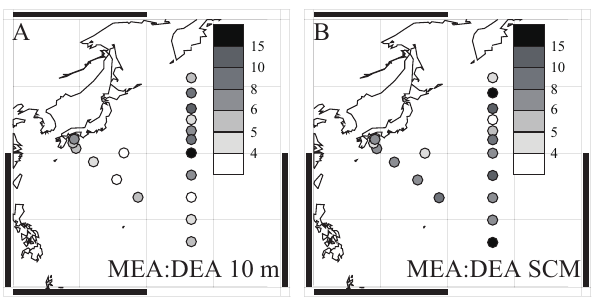
Fig. 4 Fig. 4. The ratio of phosphate monoesterase activity to diesterase activity at 10m depth (A) and subsurface chlorophyll maximum layer (B) during the KH-12-3